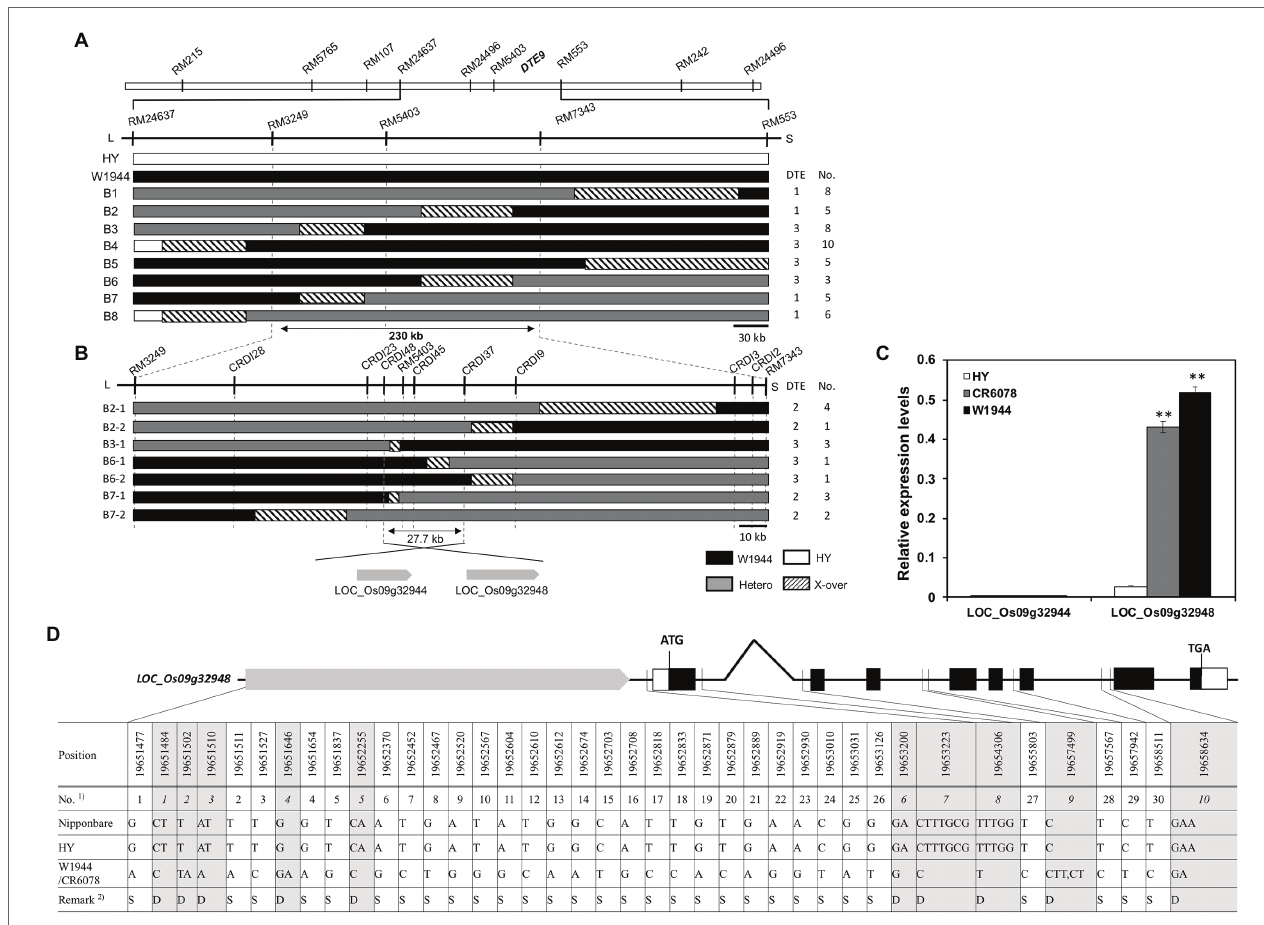
FIGURE 2 | Graphical genotypes and substitution mapping of DTE9 . (A) Substitution mapping of DTE9 OR using F 5 lines. Comparison of the genotypes of lines delimiting DTE9 OR between the markers RM3249 and RM7343. Physical distance is about 230-kb based on the Nipponbare sequence. (B) High-density mapping of DTE9 . Comparison of the genotypic recombinants delimiting DTE9 between the markers CRDI37 and CRDI48. White, black, and gray bars indicate homozygous and heterozygous alleles for HY and W1944 and hatched areas indicate regions where the crossing-over occurred on chromosome 9. Two genes were predicted in the target 27.7 kb region. (C) Expression levels of the DTE9 candidate genes in the three cultivars. Total RNA was isolated from 7-day-old seedlings of the three lines. Relative expression level of each gene was quantified using real-time PCR and normalized using OsTMP1 as an internal control. The relative transcript levels of DTE9- involved candidate genes (LOC_Os09g32944, LOC_Os09g32948). The significant differences between the HY and CR6078 plants and the HY and W1944 at ** p < 0.01. (D) Comparison of promoter and genomic sequence of OsMASD8 in HY and W1944. A total of 30 single nucleotide polymorphisms (SNPs) and 10 InDels was identified between HY and W1944. 1) SNP and InDel are separately numbered in bold and italics, respectively. 2) S: SNP, D: InDel.